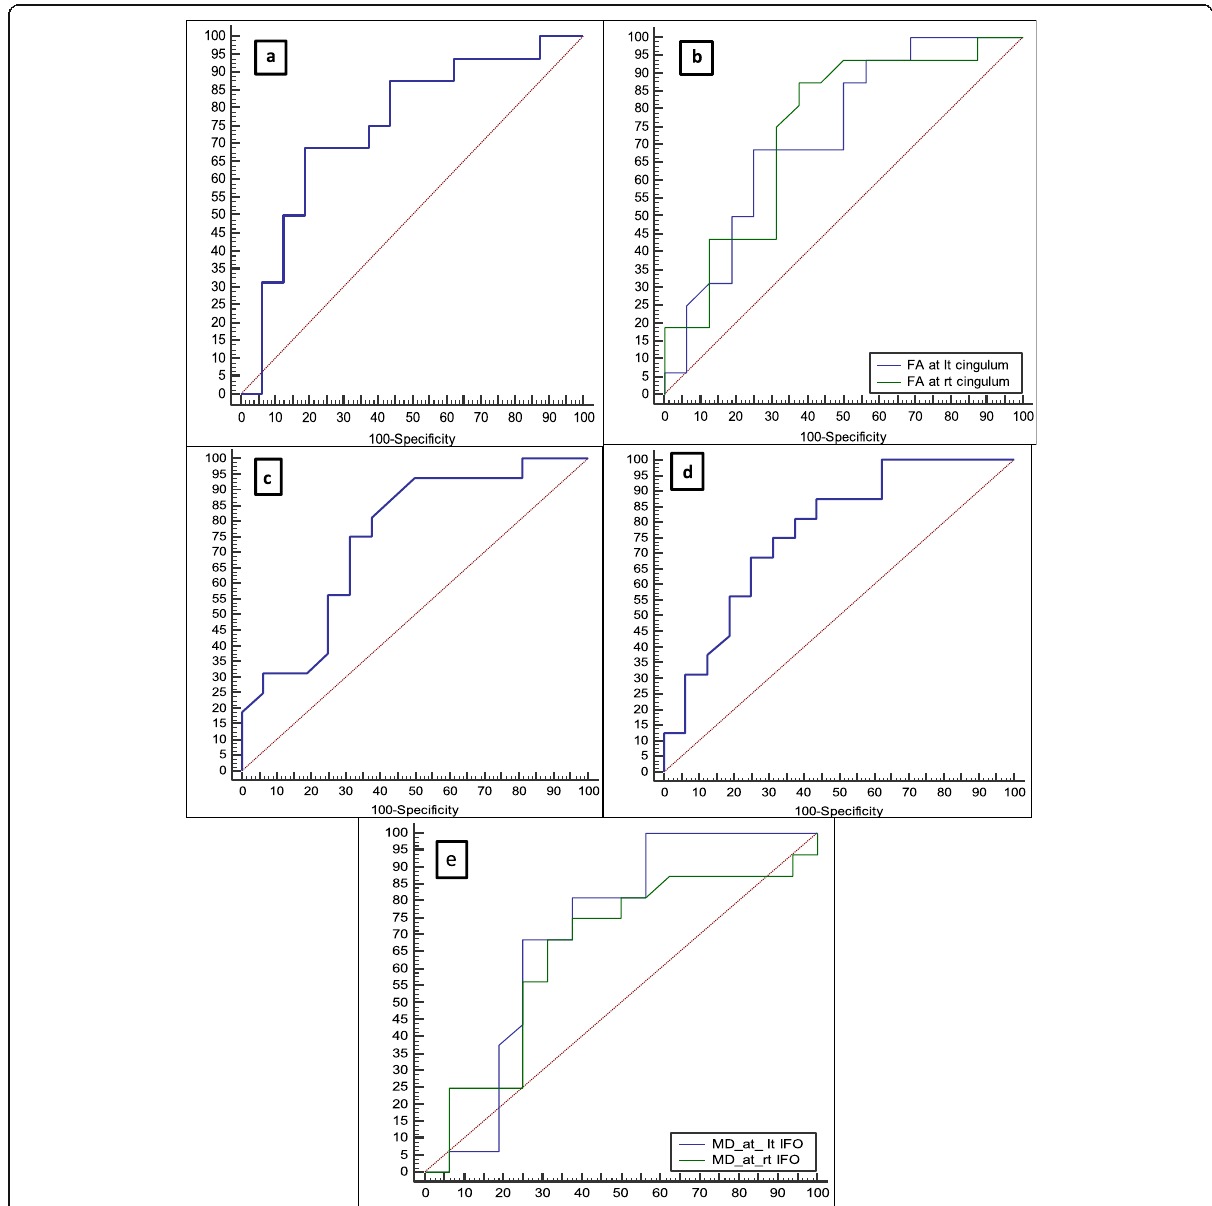
arcuate fasciculus; IFOF, inferior fronto-occipital fasciculus; UF, uncinate fasciculus; FA, fractional anisotropy; MD, mean